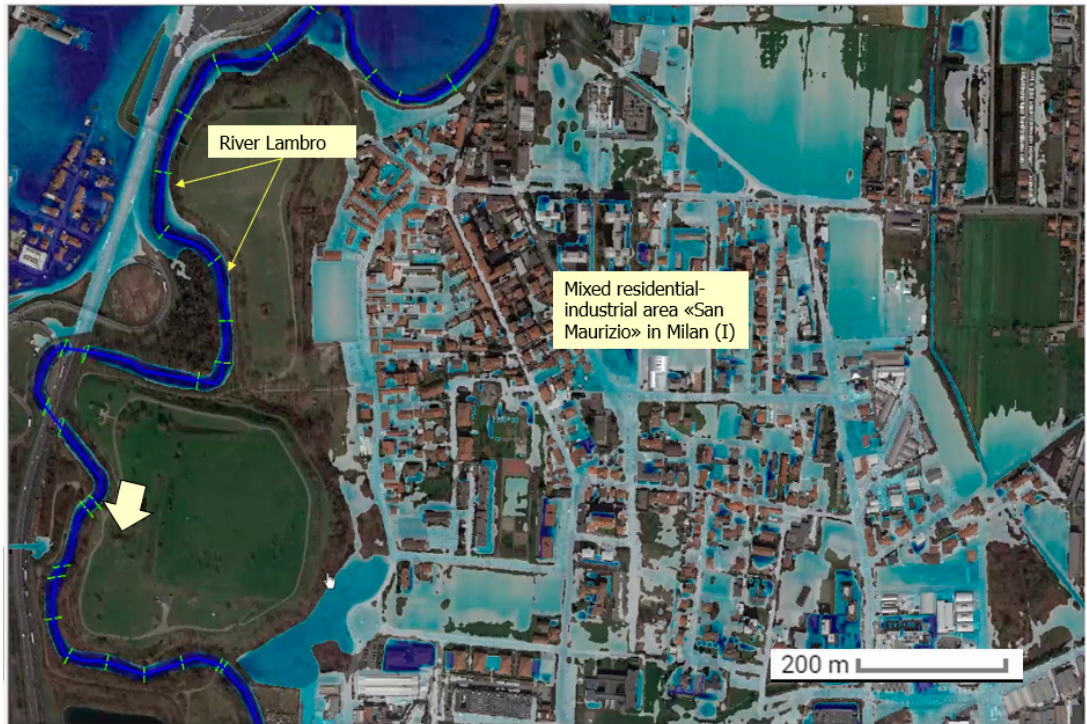
Figure 7. Rivers will flood urban areas as well; such areas must be equipped and prepared to minimize damages (Lambro river at San Maurizio al Lambro in Milan (I), in a simulation of a T R 200 event, by kind concession of Alessandro Balbo).